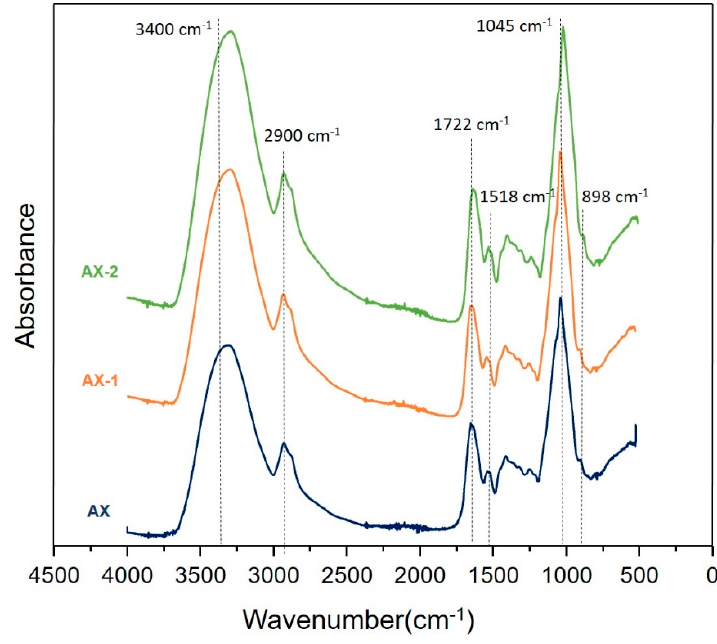
Figure 2. FT-IR spectra of AX treated with ultrasonication. Untreated AX (AX), AX treated at 25% power for 15 min (AX-1), and AX treated at 50% power for 15 min (AX-2).